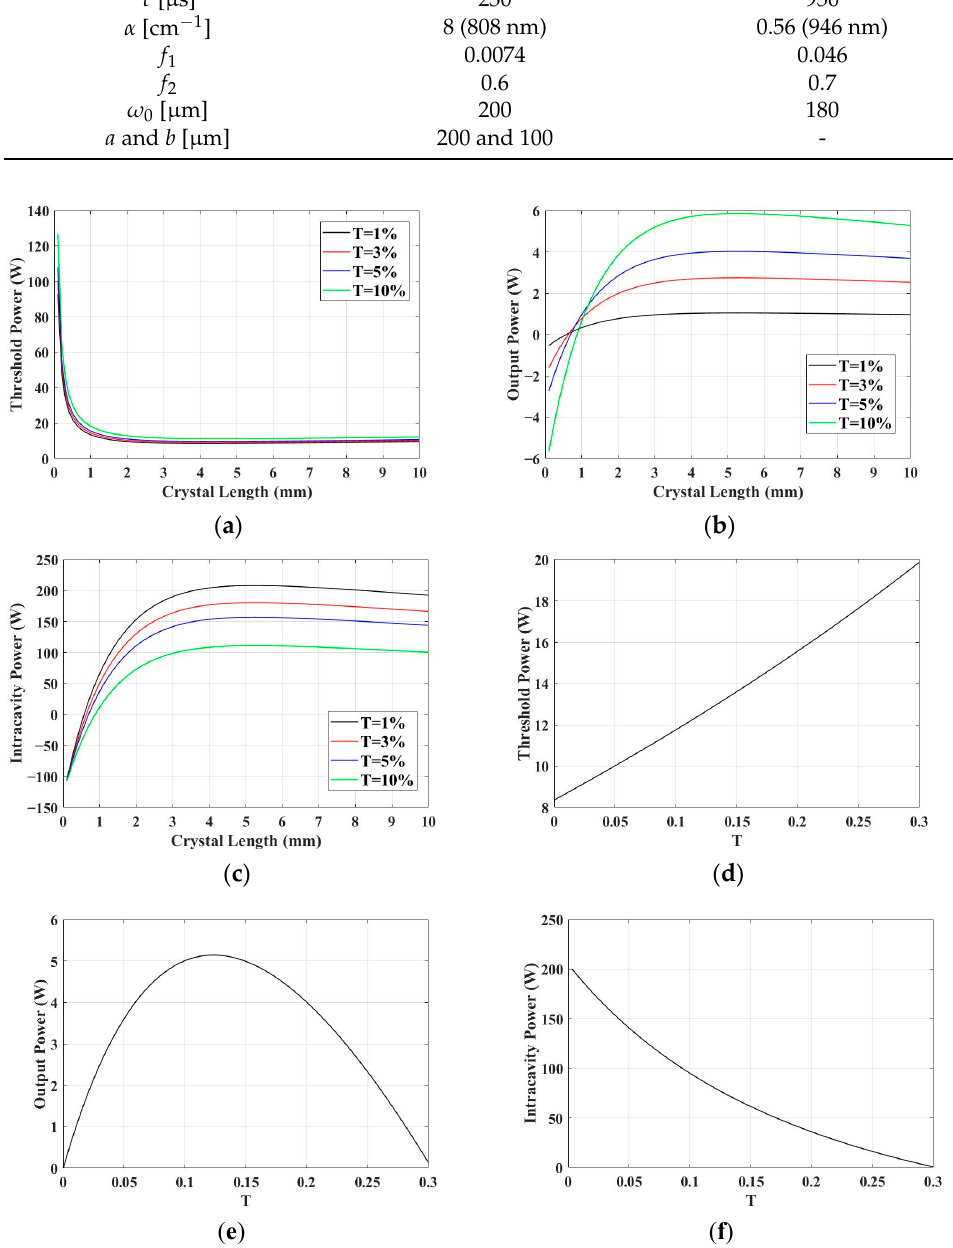
Figure 3. The relationship between ( a ) the threshold pump power, ( b ) output power, and ( c ) in- tracavity power of the 946 nm LG 01 mode vortex laser and the length of the Nd:YAG crystal at a pump power of 20 W; the relationship between ( d ) the threshold pump power, ( e ) output power and ( f ) intracavity power of the 946 nm LG 01 mode vortex laser and the output mirror transmittance at a pump power of 20 W and Nd:YAG crystal length of 3 mm.